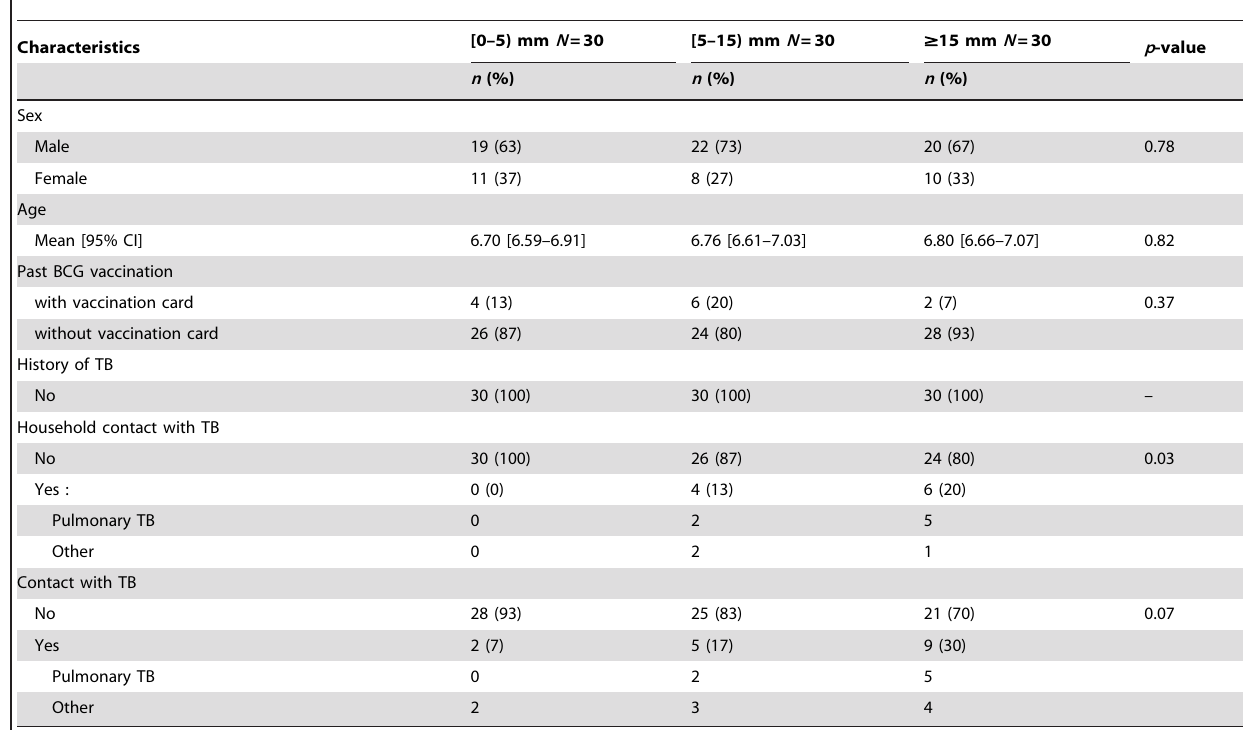
Table 1. Characteristics of the groups of schoolchildren defined on the basis of TST results.